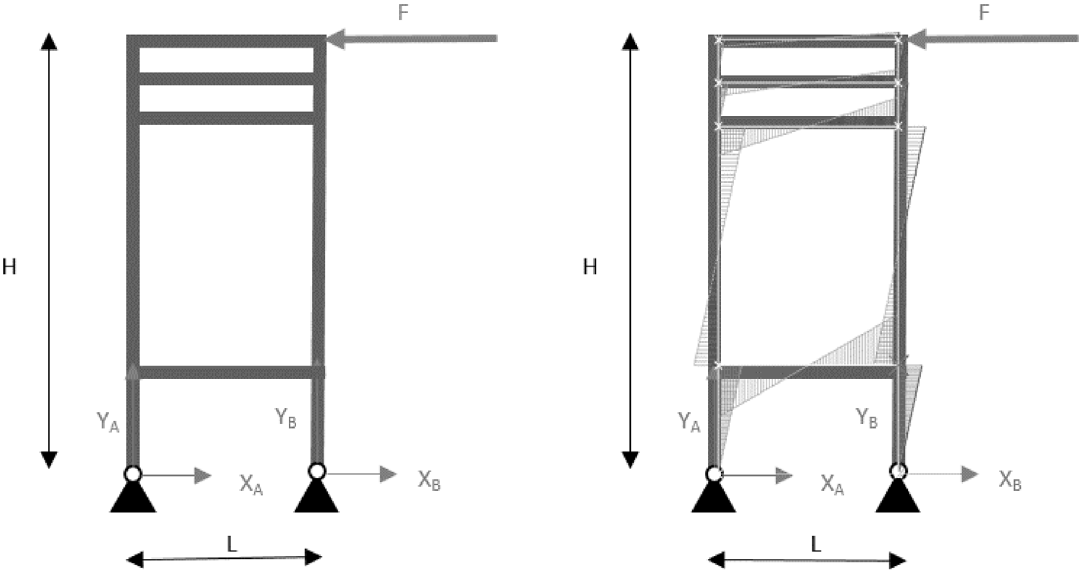
Fig. 15. Structure de fi nition and bending moment diagram of the loft bed